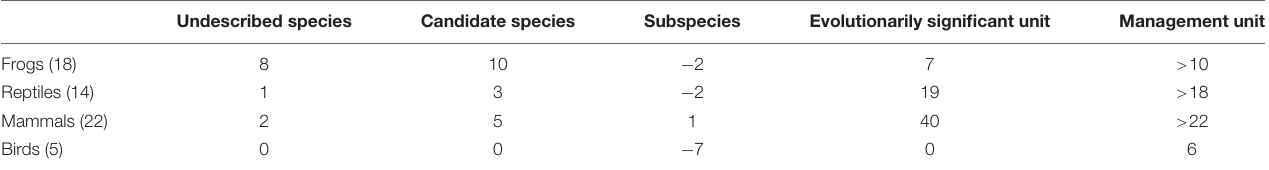
TABLE 1 | Change in number of conservation units identified by experts in the 59 species assessed, by taxonomic group (number of species assessed under current